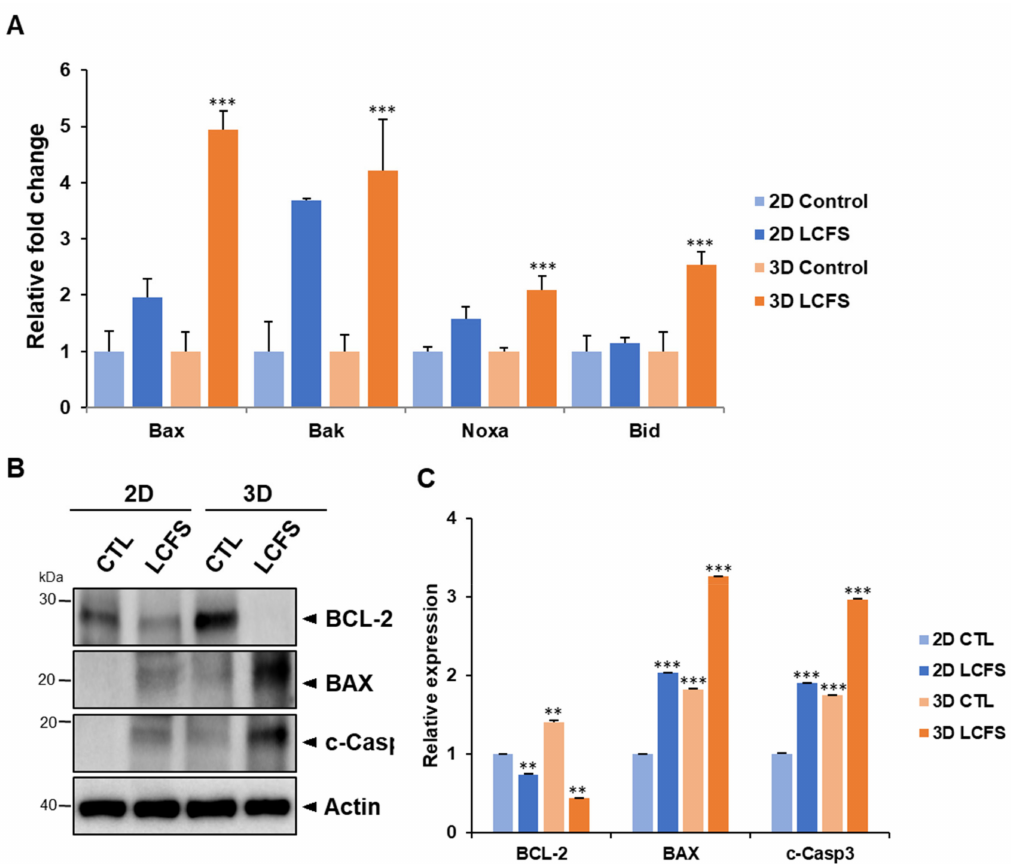
Figure 4. LCFS-induced apoptosis markers in 2D and 3D colon cancer cells. ( A ) Comparison of the qRT-PCR analysis results of the mRNA levels of Bax, Bak, Noxa, and Bid of the control and the LCFS-treated 2D and 3D HCT-116 cells ( n = 3, ** p ≤ 0.01 *** p ≤ 0.001). ( B ) Whole cell lysates from LCFS-treated cells were immunoblotted with antibodies specific for BCL-2, BAX, and cleaved caspase 3 proteins. ( C ) Bar graph for BCL-2, BAX, and cleaved caspase 3 ratio ( n = 3, ** p ≤ 0.01 *** p ≤ 0.001).